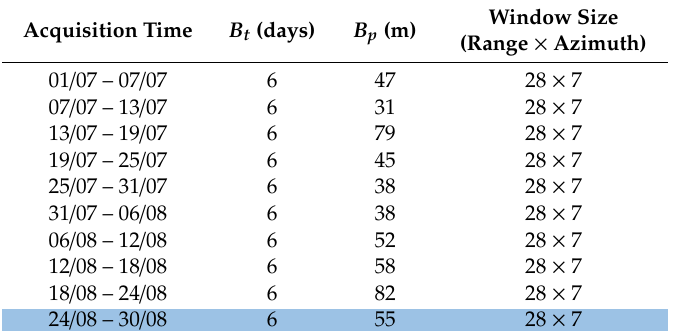
Table 2. Sentinel-1 coherence data used for the Houston case study (flood acquisition is marked in blue